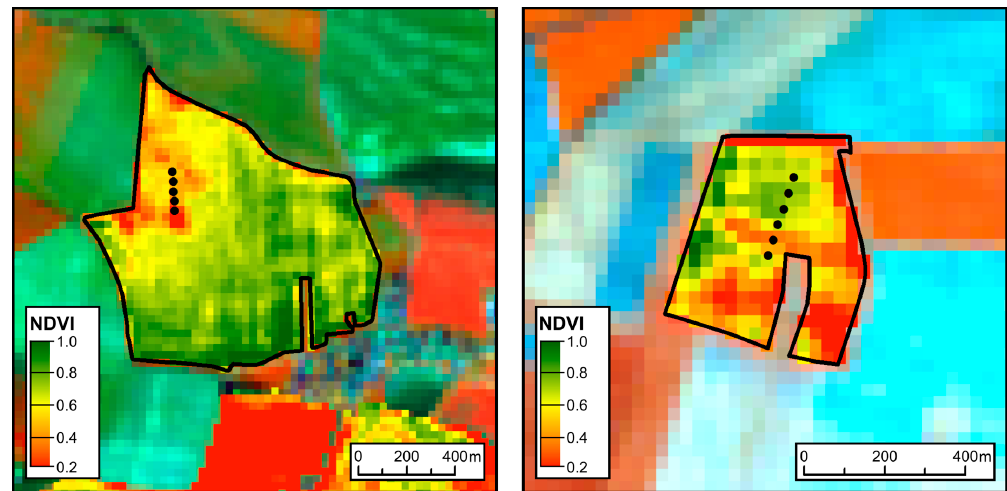
Figure 2. Selection of in situ transects. The latest cloud-free scene acquired before the date of an in situ sampling campaign (in this case 16 March 2017) was used to calculate a normalized difference vegetation index (NDVI) product. Spatial gradients of NDVI (assumed to describe spatial heterogeneity of canopy characteristics) were used for locating the sampling transect.